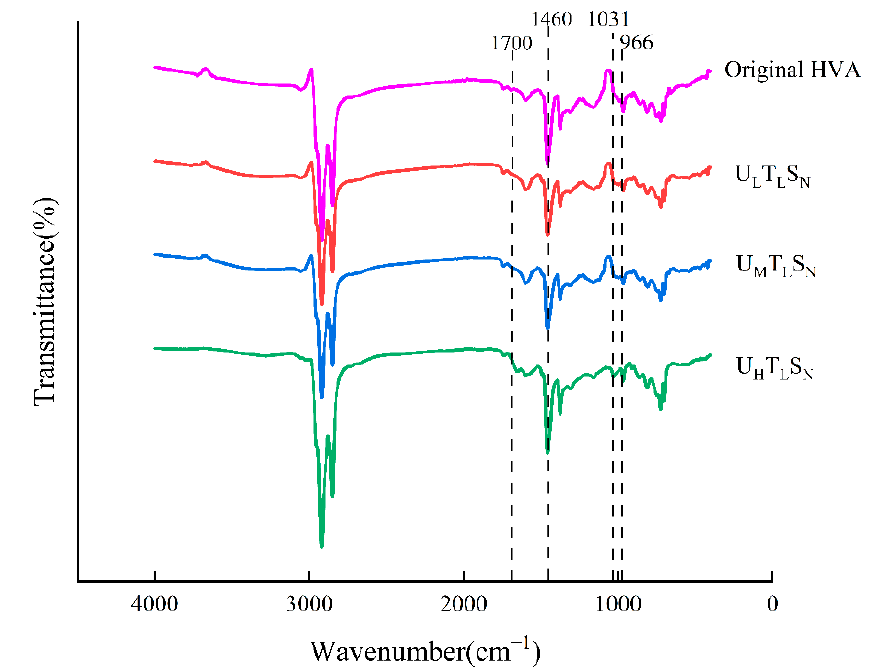
Figure 3. Variation of the spectrum of different asphalt samples under different ultraviolet irradia- tion intensities.